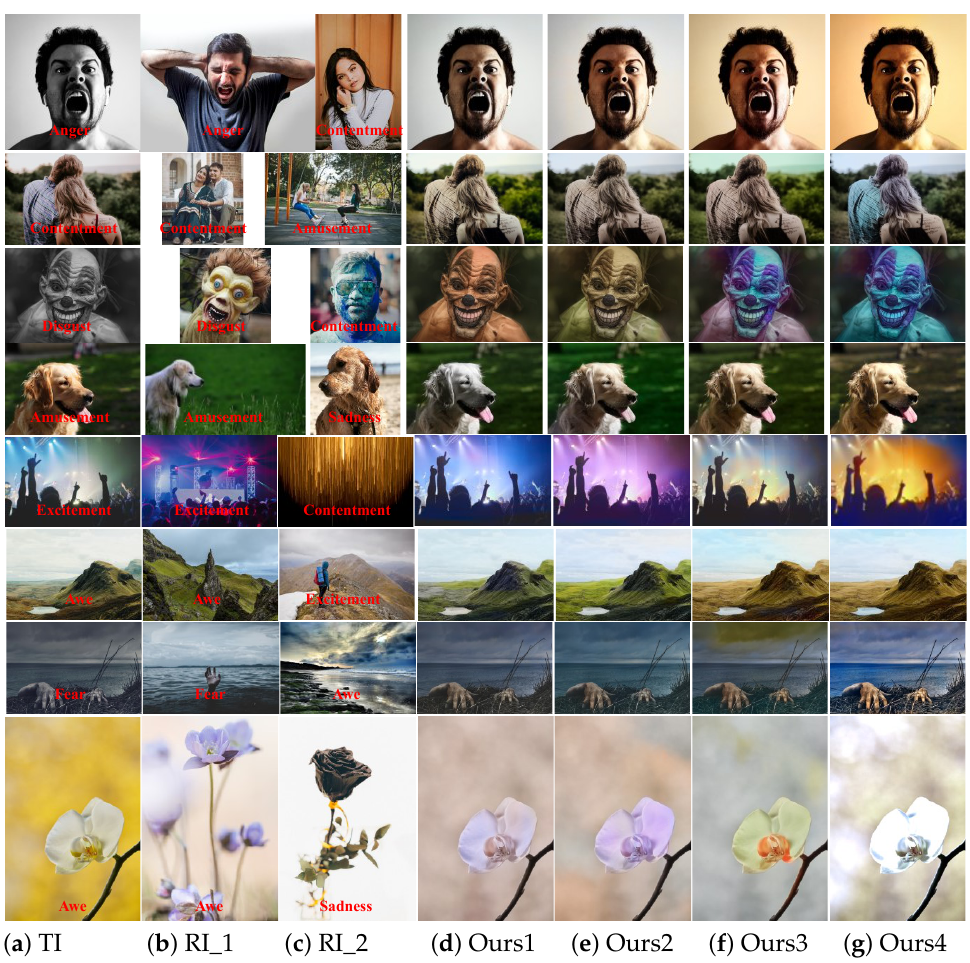
Figure 9. Influence of emotion classification labels on coloring effect. These columns correspond in turn to the target image (TI), reference image 1(RI_1), reference image 2 (RI_2), result 1 (Ours1), result 2 (Ours2), result 3 (Ours3), and result 4 (Ours4). Results 1 and 2 are generated by our model based on reference image 1, results 3 and 4 are generated by our model based on reference image 2. Results 1 and 3 are the generation effects of our model without emotional labels, results 2 and 4 are the generation effects of our model with emotional